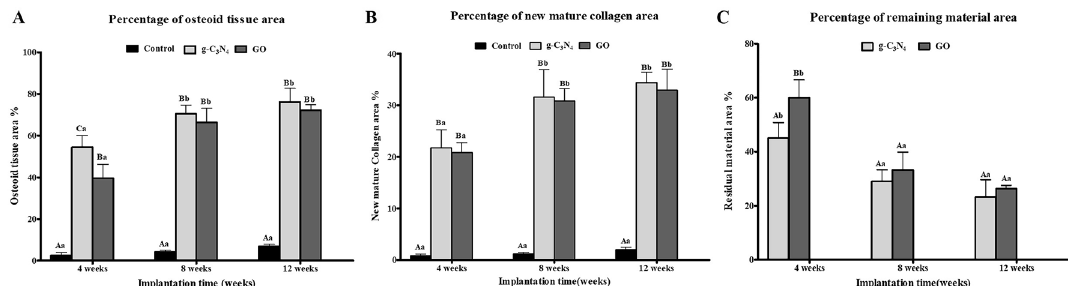
Figure 6. In vivo histomorphometrical analysis. The percentages of osteoid tissue area ( A ), residual material area ( B ), and new mature collagen area ( C ) to the total defect area in rabbit femoral condyle defects implanted with g-C 3 N 4 and GO or left empty at various times post-implantation. Error bars ± SD; n = 3 for each group and time point. Bars with the same letter represent values that are not significantly different (two-way ANOVA followed by Tukey’s HSD post hoc test). ( A – C ) significance between groups; a, b, and c: significance between time points within the same group.